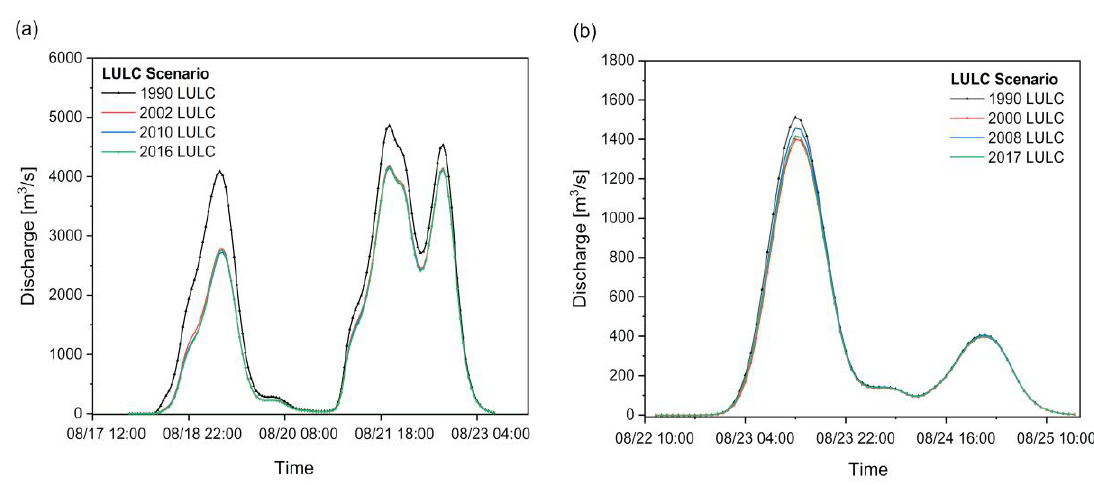
Figure 9. Simulated hydrographs for different land use land cover scenarios at the Yanhe ( a ) and Guangyuan ( b ) watersheds.